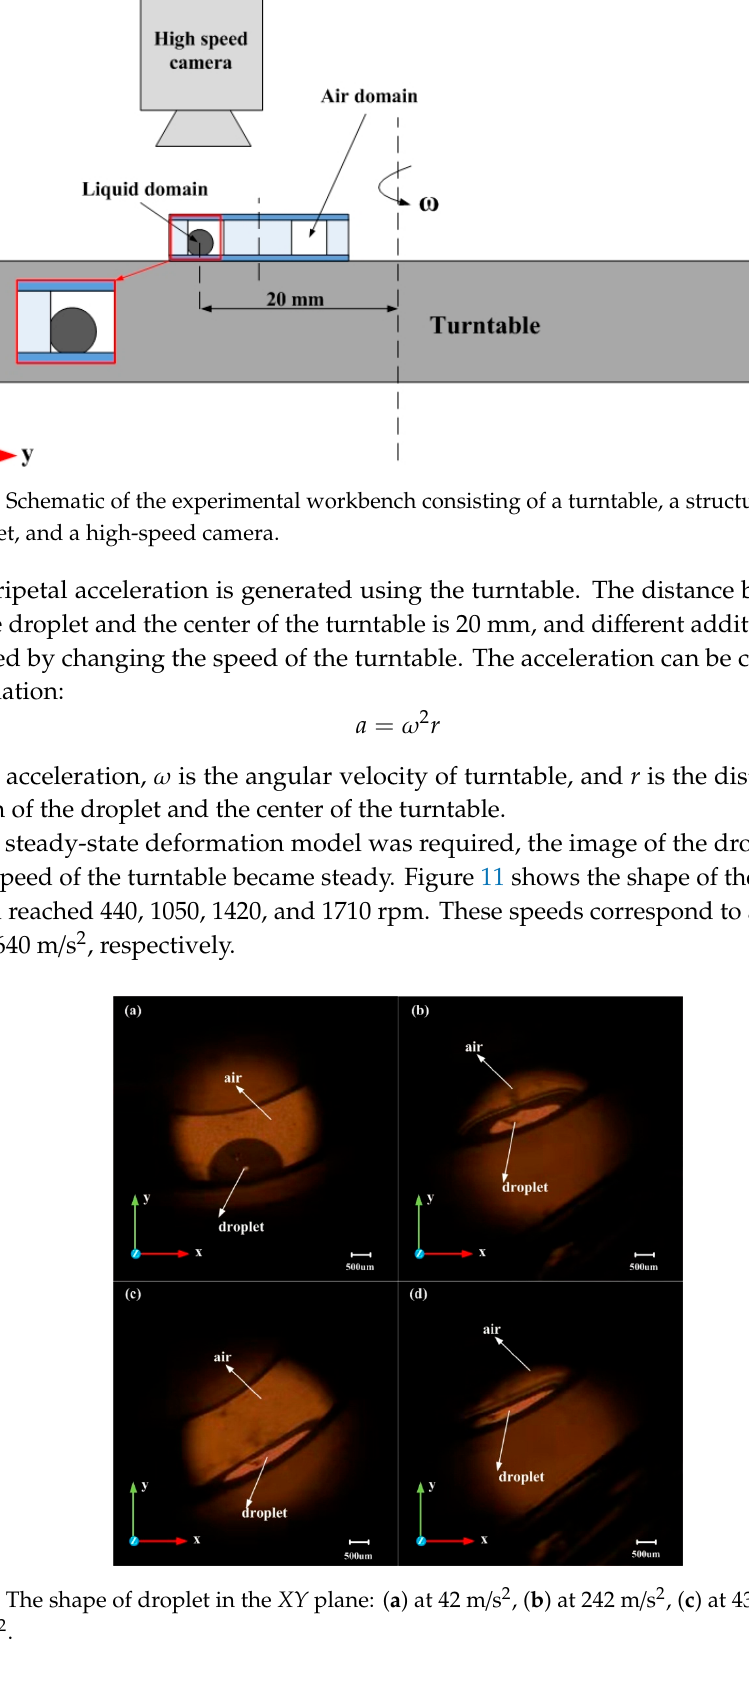
Table 5. The boundary conditions of the model.